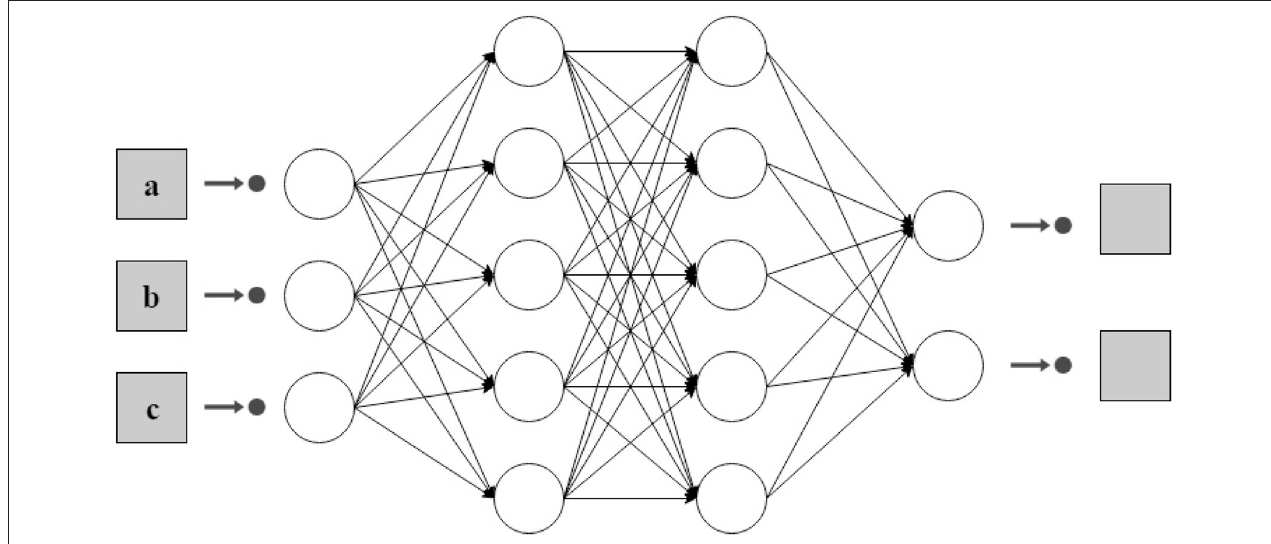
FIGURE 4 | An example of and architecture of two hidden layers for a dataset with three attributes and two possible